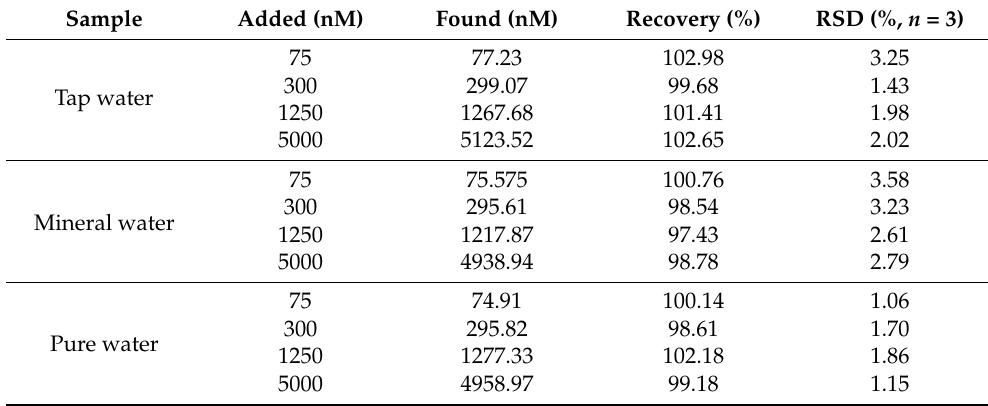
Table 1. Analytical results of